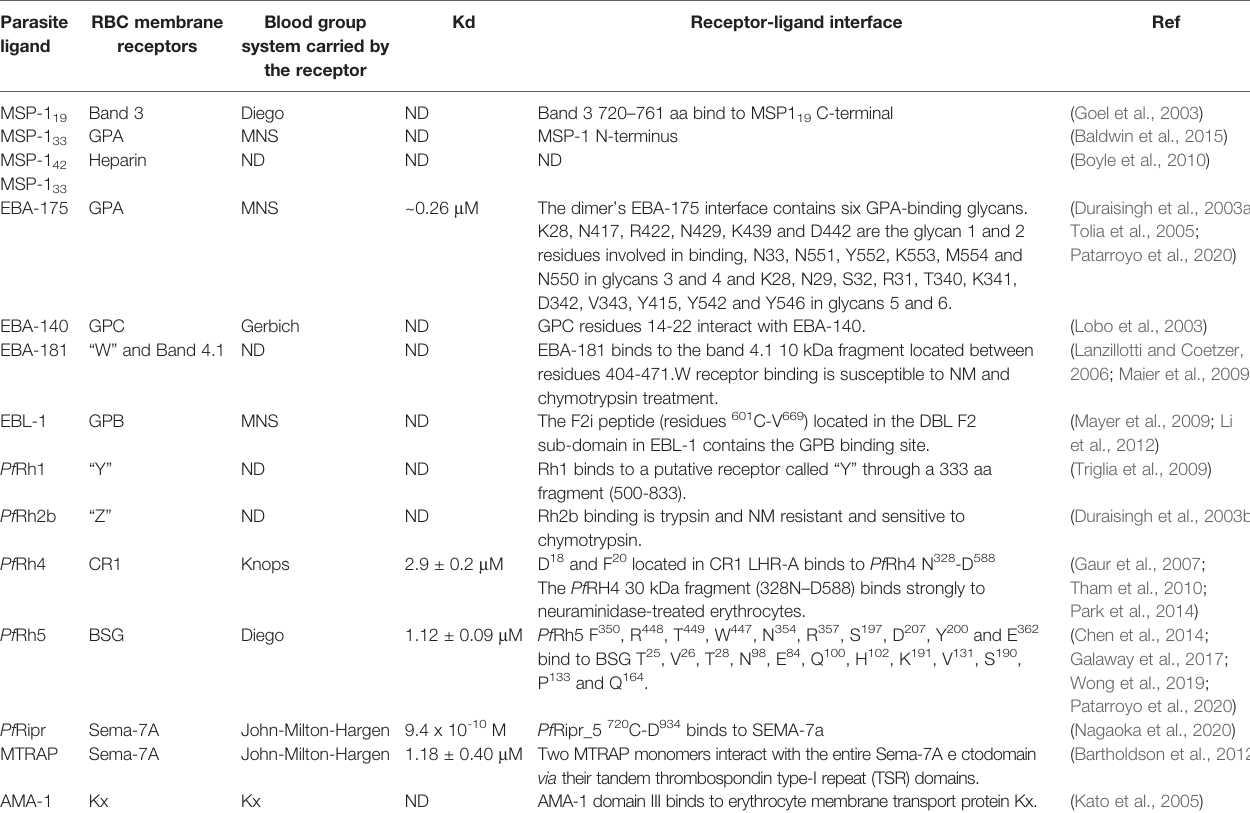
TABLE 1 | Plasmodium falciparum receptor-ligand